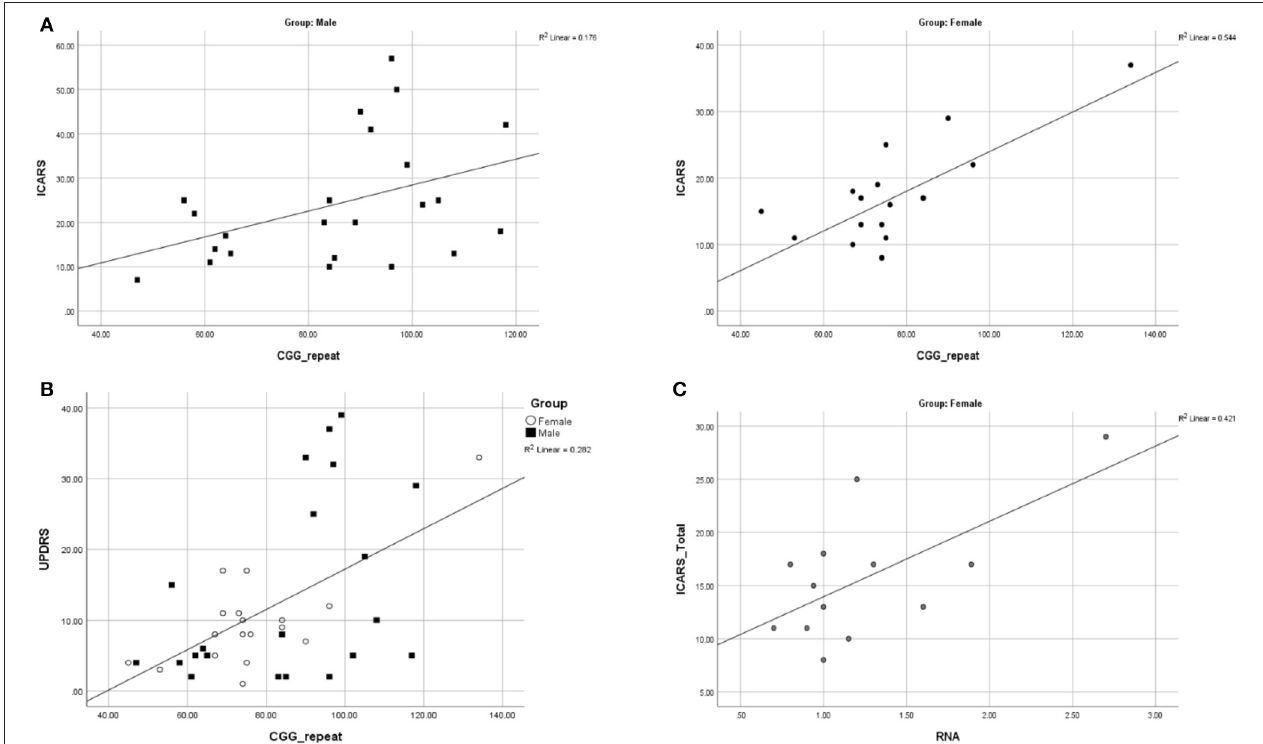
FIGURE 4 | (A) Scatterplots illustrating significant relationships between CGG repeat size and ICARS Total in males and females. (B) Scatterplot illustrating a significant relationship between CGG repeat size and UPDRS in males and females combined. (C) Scatterplots illustrating significant relationships between FMR1 mRNA and ICARS total in